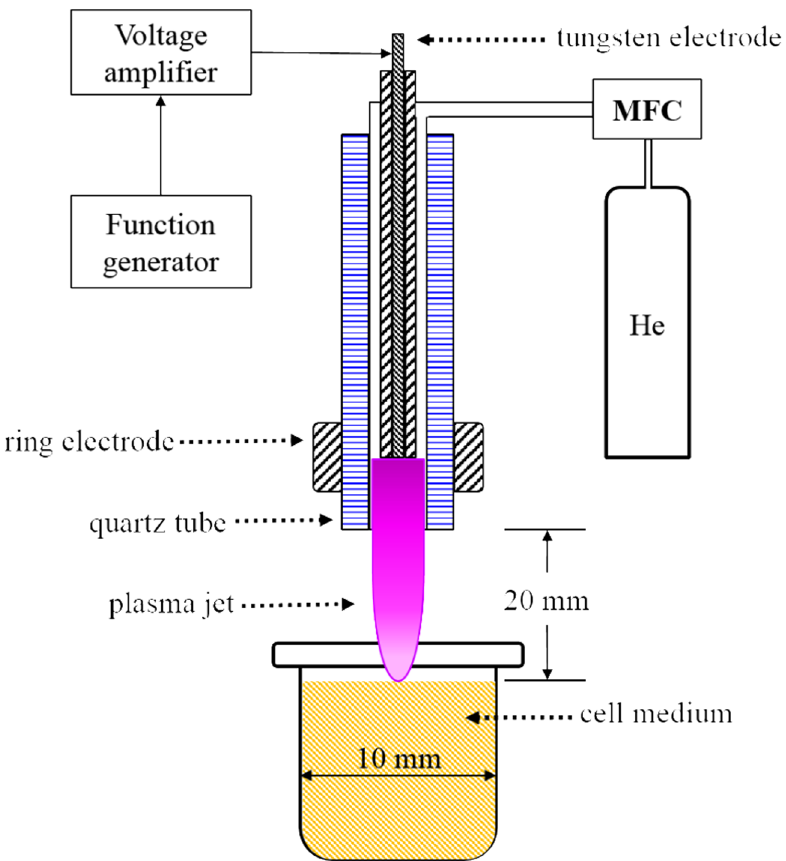
Figure 9. A schematic of APPJ injection into cell culture medium. The helium gas-flow rate is controlled by a mass flow controller. The high electric field produced between two electrodes induces breakdown of the helium gas. Then, the plasma propagates along the tube over the cell culture